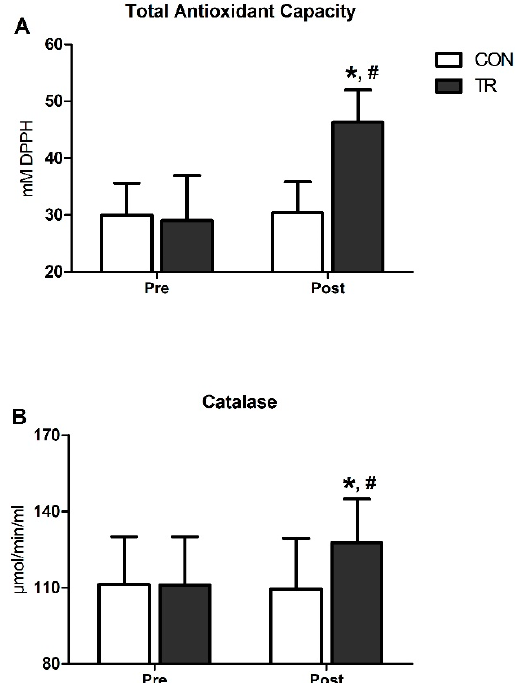
Figure 3. Six-month exercise training intervention upregulated total antioxidant capacity and catalase activity in blood. Changes in total antioxidant capacity (TAC) ( A ) and catalase (CAT) activity ( B ) in TR and CON after the 6-month intervention. Data are presented as mean ± standard deviation. *Significant difference with pre-training values ( p < 0.05); #Significant difference with the CON group ( p < 0.05).